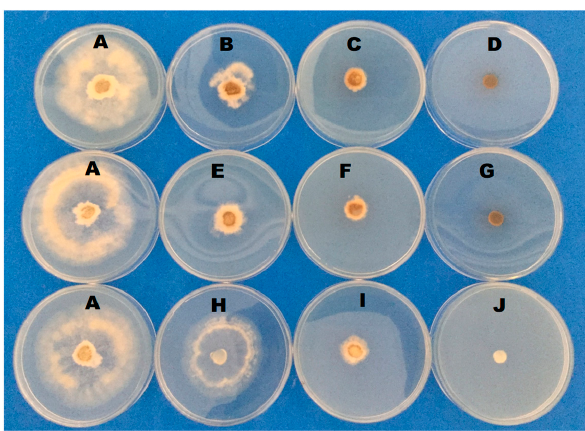
Figure 4. Effect of three concentrations of potassium bicarbonate (PB), sodium silicate (SSi),